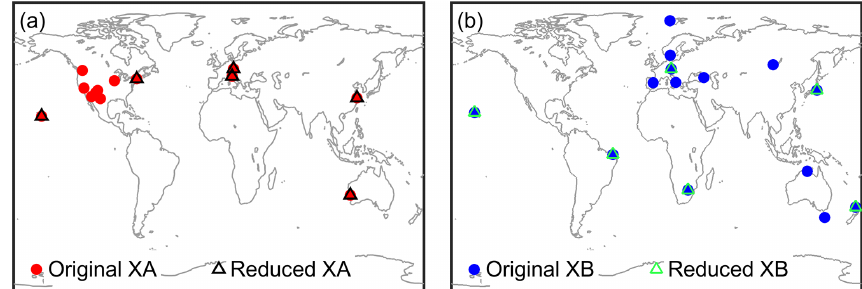
Figure 1. Station distribution of the CONT17 XA (a) and XB (b) original and reduced